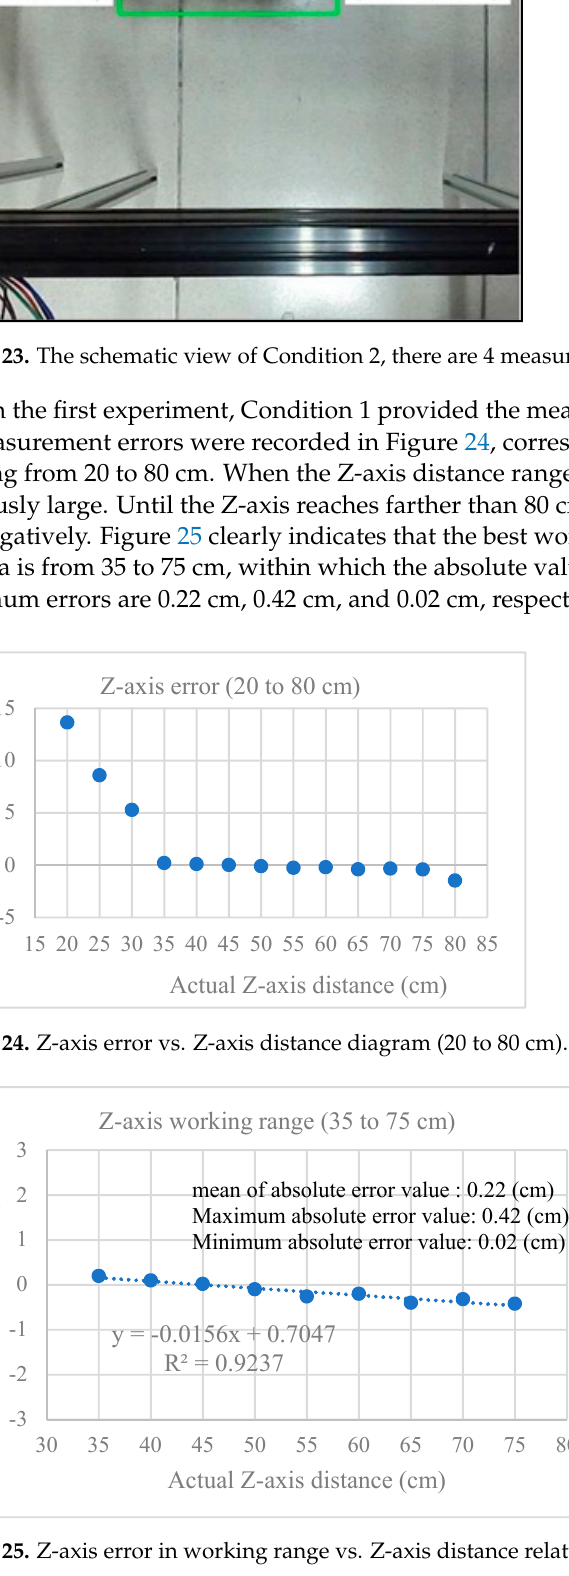
Figure 25. Z-axis error in working range vs. Z-axis distance relationship diagram (35 to 75 cm). Additionally, Condition 2 was used for the second experiment. The measurement results were addressed in Table 1. The maximum absolute errors of the X-, Y-, and Z-axes of the four measurement points are 0.18 cm, 0.2 cm, and 0.32 cm, respectively. On the other hand, the minimum absolute errors of the X-, Y-, and Z-axes of the four measurement points are 0.1 cm, 0.12 cm, and 0.18 cm, respectively. It is shown that the resulted four measurements in Figure 23 deviate from the accurate positions with mm-scale errors, which is relatively little in comparison with the nozzle size. Therefore, it can be guaran- teed that the nozzle still waters on the correct position, despite the presence of the meas- urement errors presented in Table 1. Table 1. Measurement results of seedling center. Measurements